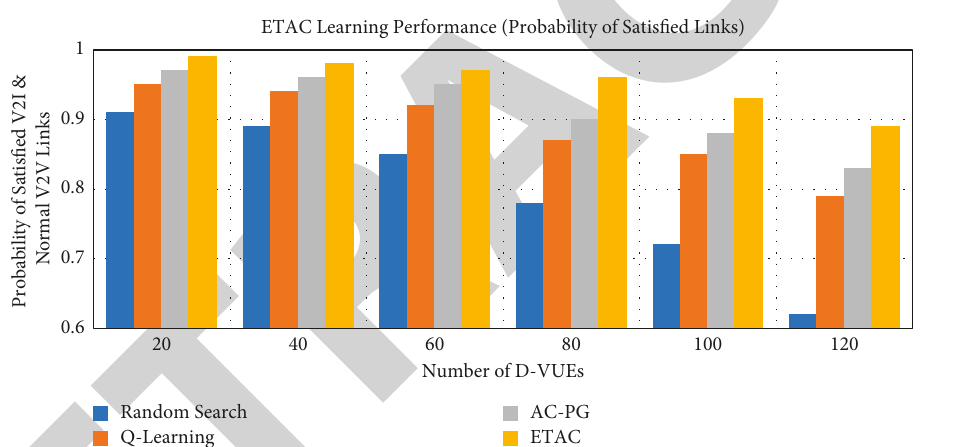
Figure 7: ETAC agent performance in the V2V-D2D communications.